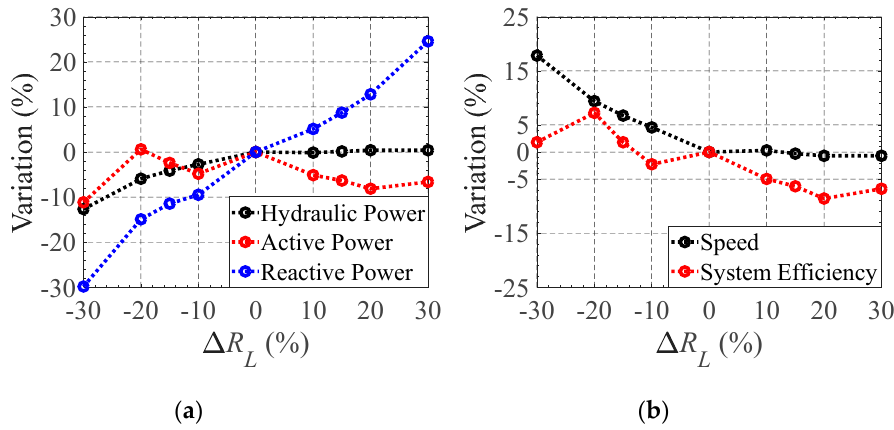
Figure 19. Variation of hydraulic and electromechanical parameters after a change in the resistive load, R L : ( a ) variation of hydraulic (black), active (red) and reactive (blue) powers, and ( b ) variation of speed (black) and system (red) efficiency.